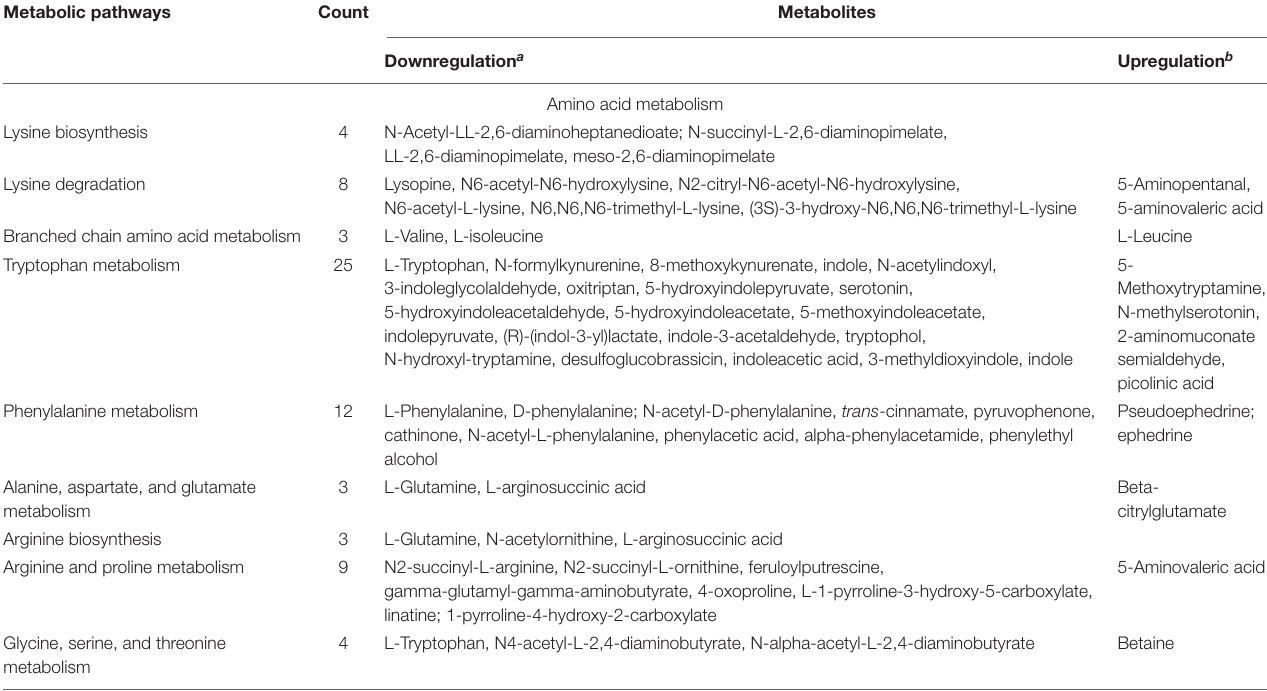
TABLE 4 | Key differential metabolites and their pathways annotated by KEGG. Metabolic pathways